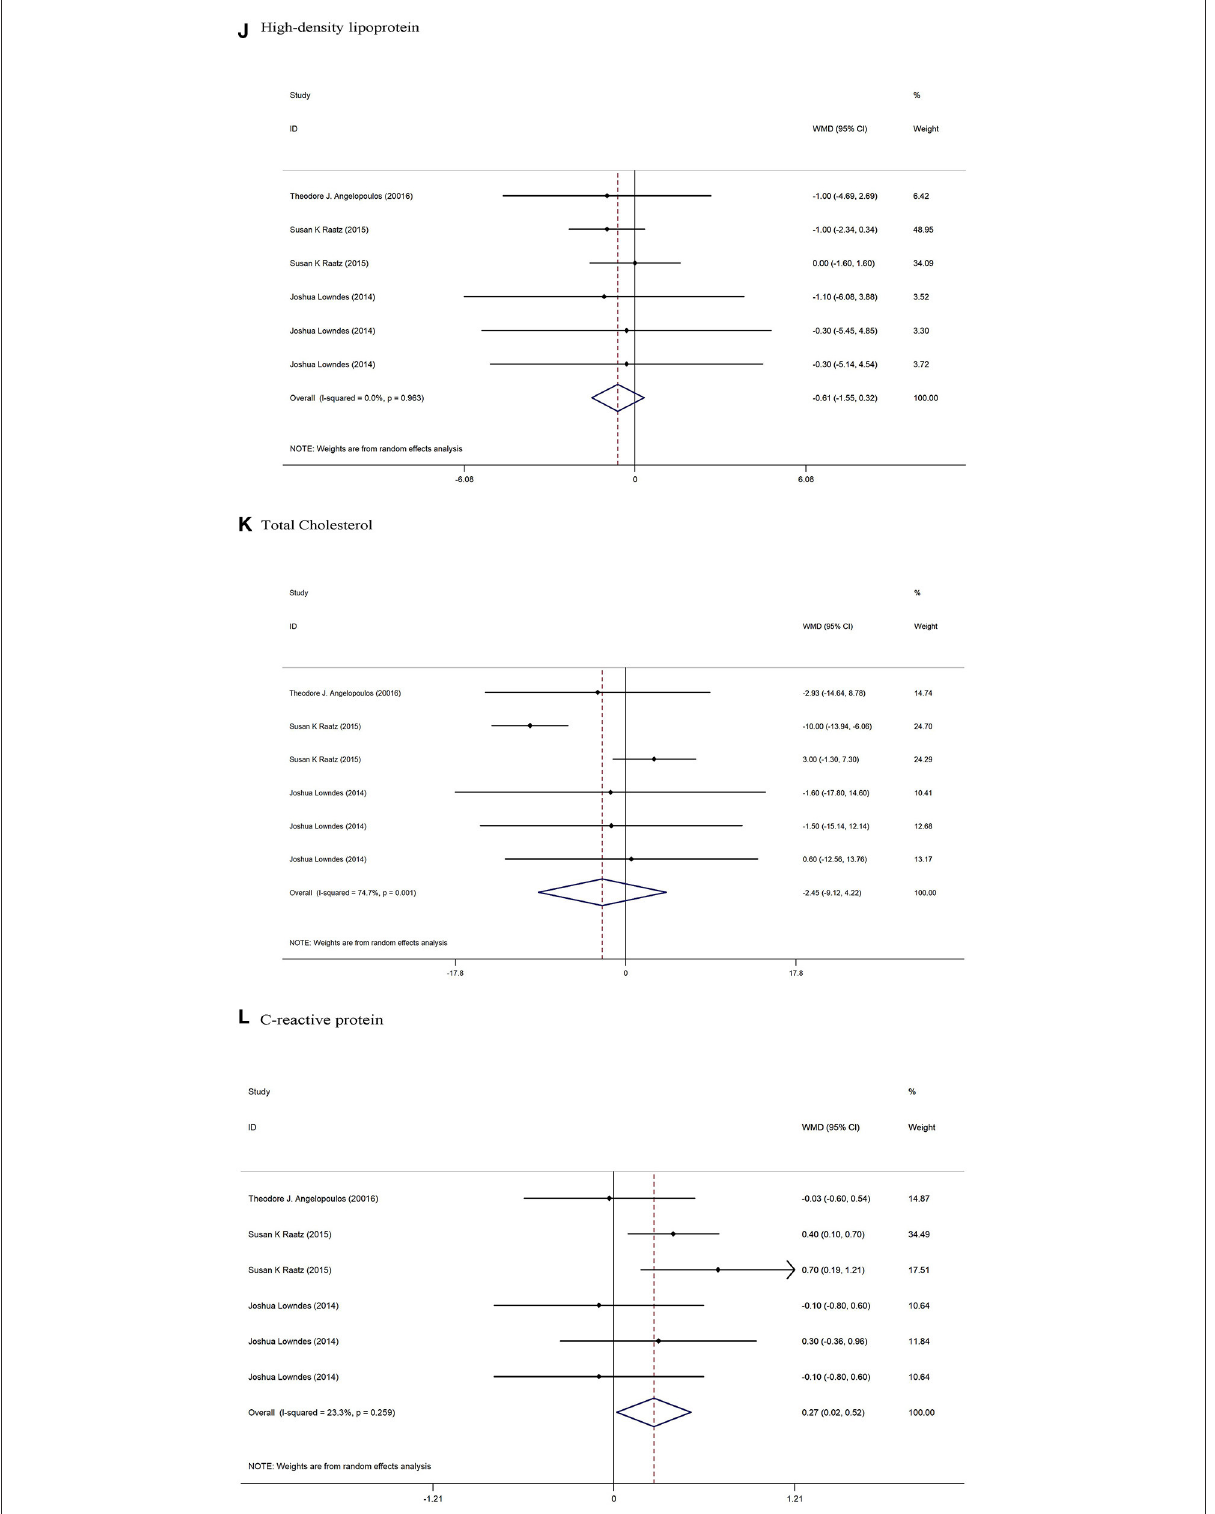
FIGURE3 Meta-analysis of effect of High-fructose corn syrup on. (A) Weight. (B) Waist circumstance. (C) Body mass index. (D) Fat mass. (E) Systolic blood pressure. (F) Diastolic blood pressure. (G) Fasting blood glucose. (H) Triglyceride. (I) Low-density lipoprotein. (J) High-density lipoprotein. (K) Total Cholesterol. (L) C-reactive